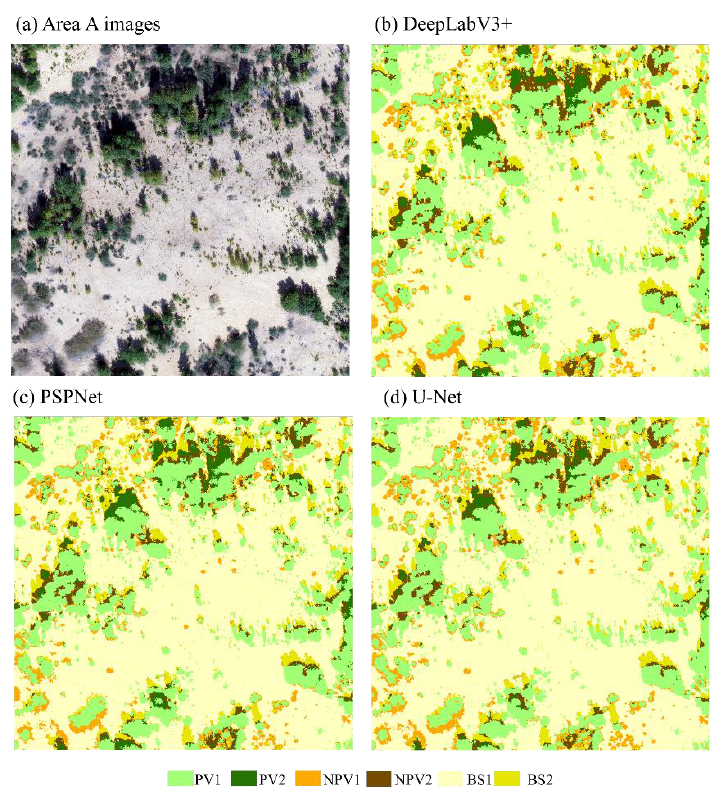
Figure 5. Region A (September) estimation results under different semantic segmentation models. ( a ) Original images; ( b ) Estimation results by DeepLabV3+; ( c ) Estimation results by PSPNet; ( d ) Estimation results by U-Net. Table 2. Accuracy of the results under different semantic segmentation